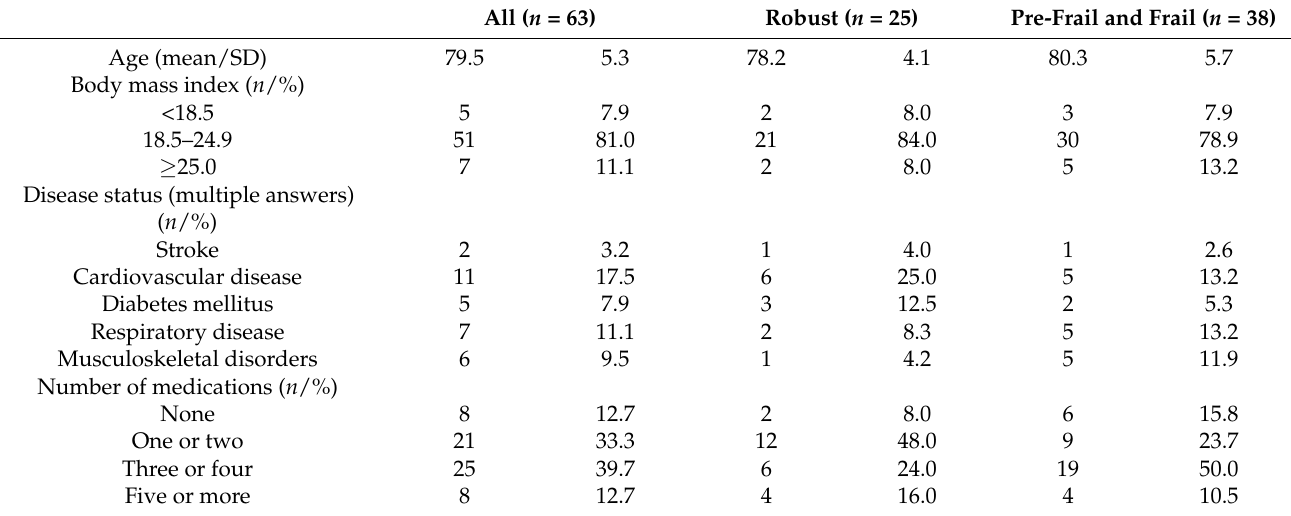
Table 3. Characteristics of the participants at